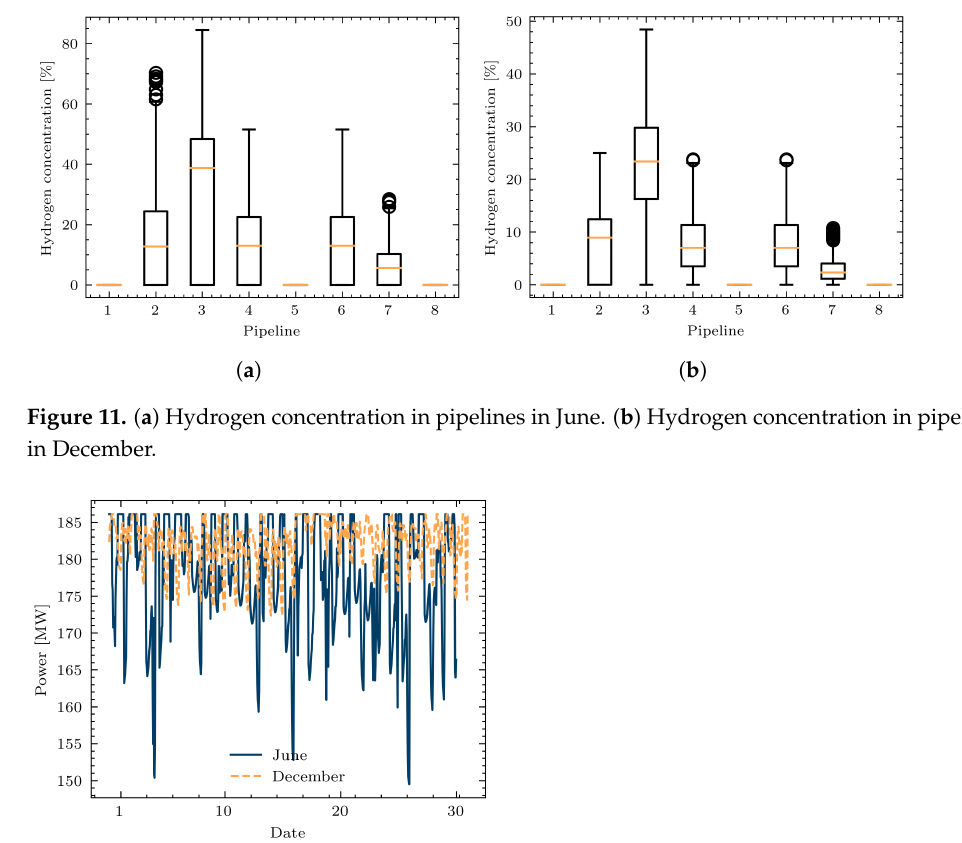
Figure 12. Gas-fired power plant generation with constant volumetric flow